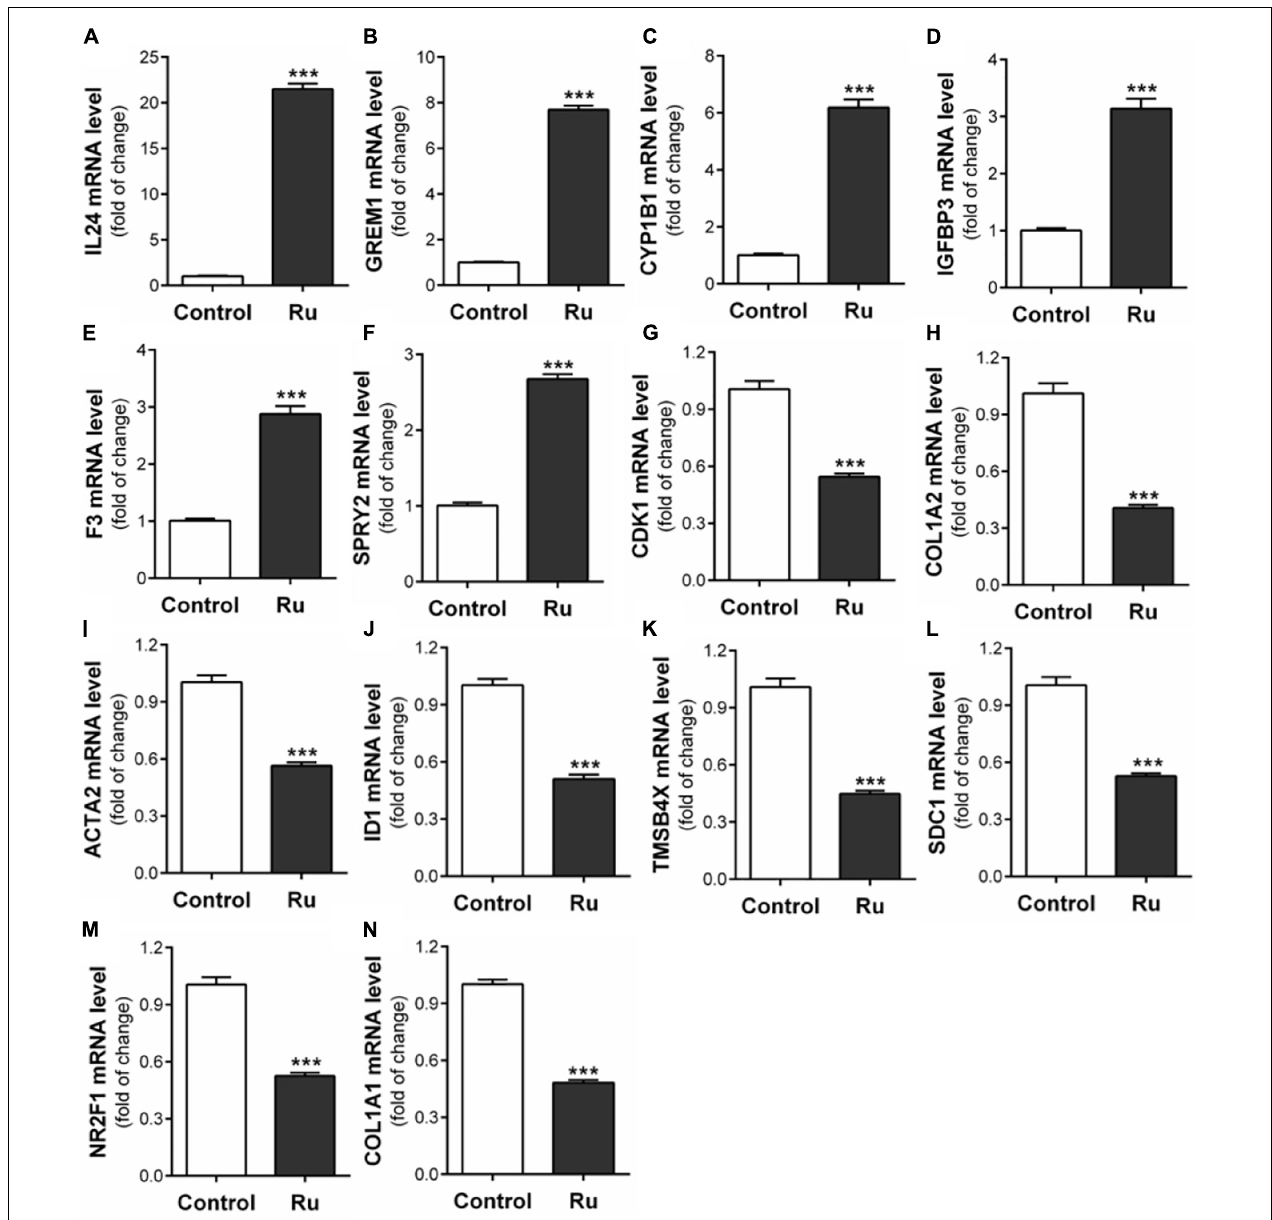
FIGURE 8 | Verification of fourteen migration related genes in RNA-seq results. After U87 cells were treated with rutaecarpine for 48 h, the mRNA expressions of (A) IL24, (B) GREM1, (C) CYP1B1, (D) IGFBP3, (E) F3, (F) SPRY2, (G) CDK1, (H) COL1A2, (I) ACTA2, (J) ID1, (K) TMSBAX, (L) SDC1, (M) NR2F1, and (N) COL1A1 were determined by qPCR analysis. GAPDH was used as an internal control for quantification. *** p < 0.001 compared with control group. All values are fold of control that was treated with the solvent and represent the mean ± SEM ( n = 3). SEM, standard error of the mean; Ru,